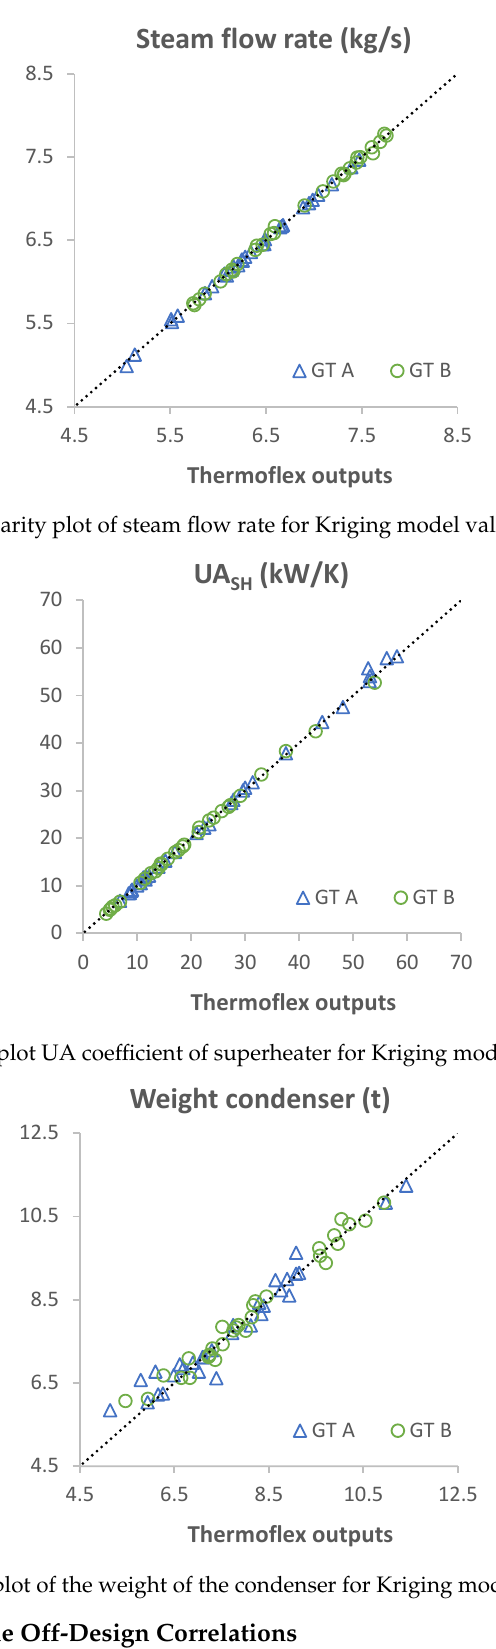
Table A2. Designs selected to test the off-design correlations.